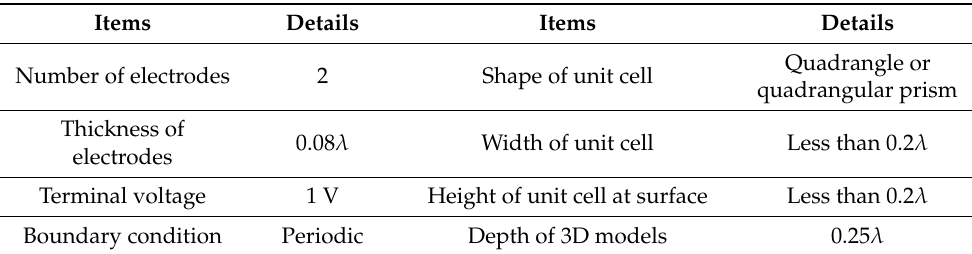
Quadrangle or quadrangular prism